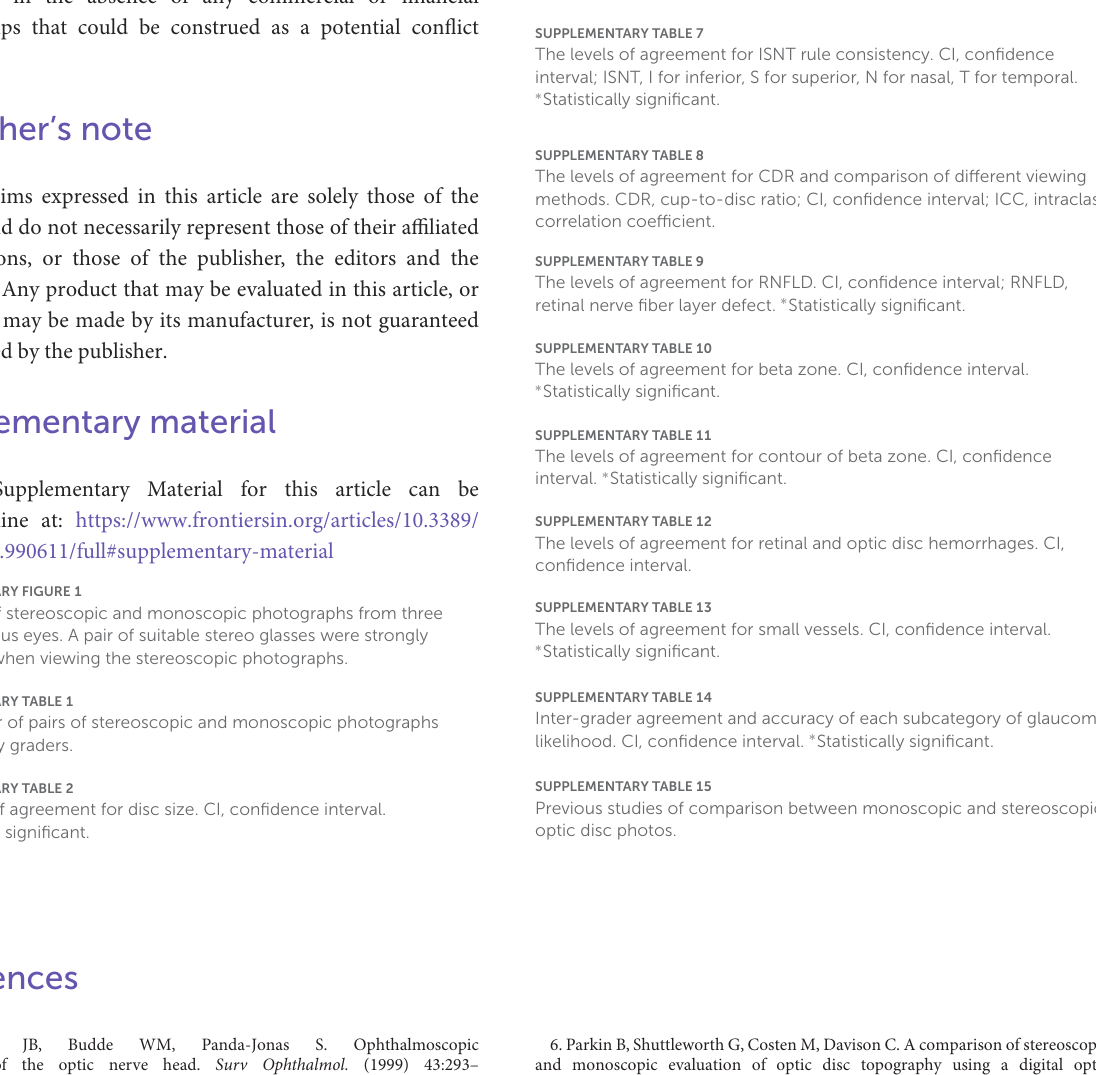
SUPPLEMENTARYTABLE3 The levels of agreement for disc color. CI, confidence interval. ∗ Statistically significant. SUPPLEMENTARYTABLE4 The levels of agreement for disc shape. CI, confidence interval. ∗ Statistically significant. SUPPLEMENTARYTABLE5 The levels of agreement for disc contour. CI, confidence